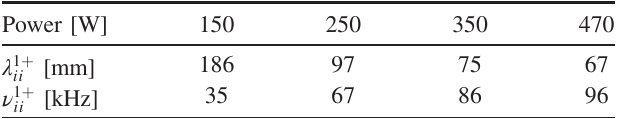
TABLE II. Estimated mean-free paths and lower limits of ion-ion collision frequency of 23 Na 1 þ ions injected into helium plasma.